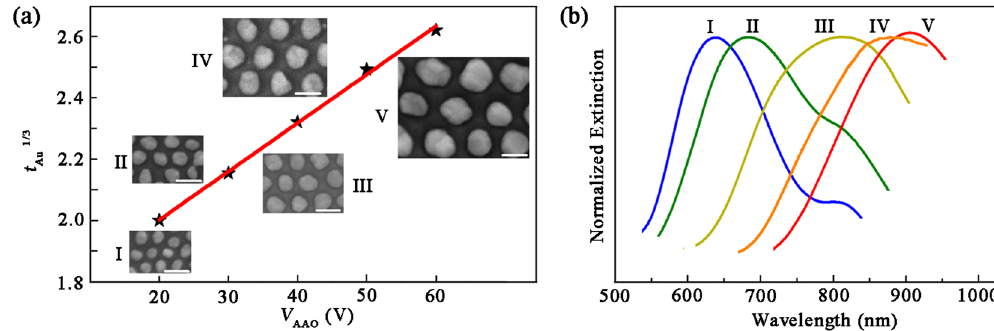
Figure 5. ( a ) The empirical relationship between V AAO and t Au based on experiment results. The insets in ( a ) give the corresponding SEM images of ‘one particle per bowl’ array with different V AAO values. ( b ) Normalized extinction spectra corresponding to the inset images in ( a ). I: V AAO = 20 V, t Au = 8.0 nm, thermal treatment for 1 h; II: V AAO = 30 V, t Au = 10.0 nm, thermal treatment for 2 h; III: V AAO = 40 V, t Au = 12.5 nm, thermal treatment for 2 h; IV: V AAO = 50 V, t Au = 15.0 nm, thermal treatment for 3 h; V: V AAO = 60 V, t Au = 18.0 nm, thermal treatment for 4 h. The scale bars in the inset of ( a ) are 100